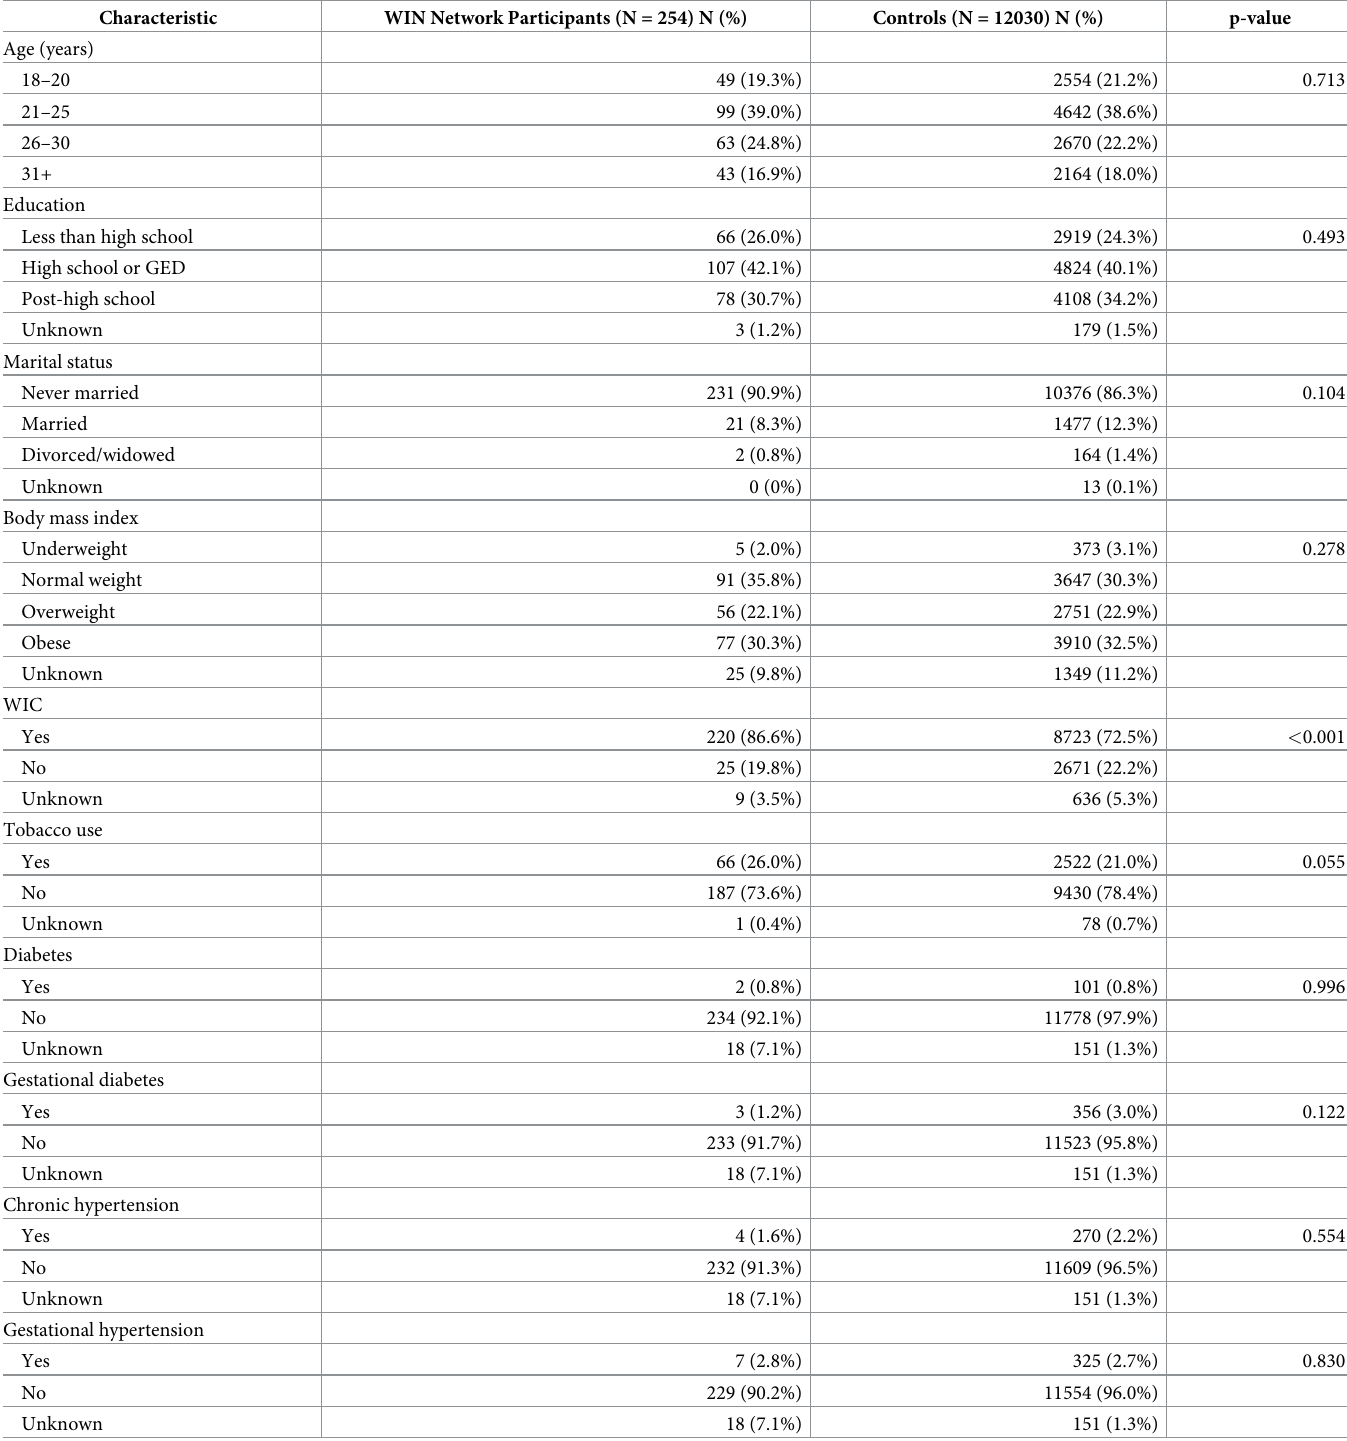
Table 1. Sociodemographic and clinical characteristics of WIN Network participants and